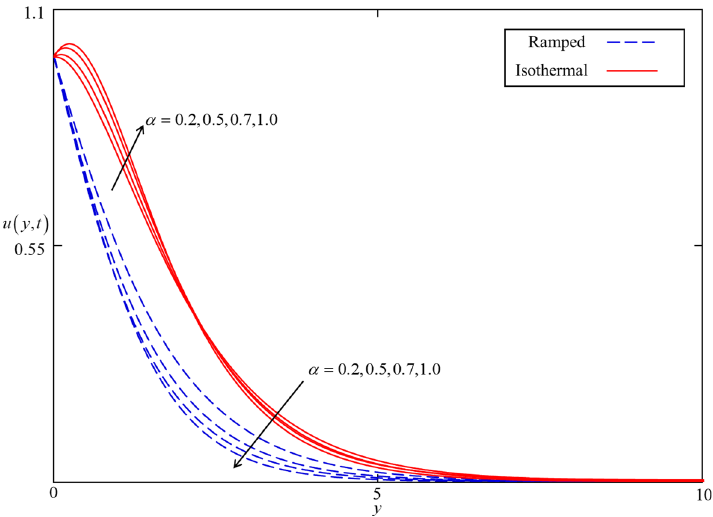
y , t when φ = 0.04 , β = 0.5 , M = 0.5 , Gr = 5 , Nr = 0.5 , Q = 0.5 and (cid:30) (cid:31)